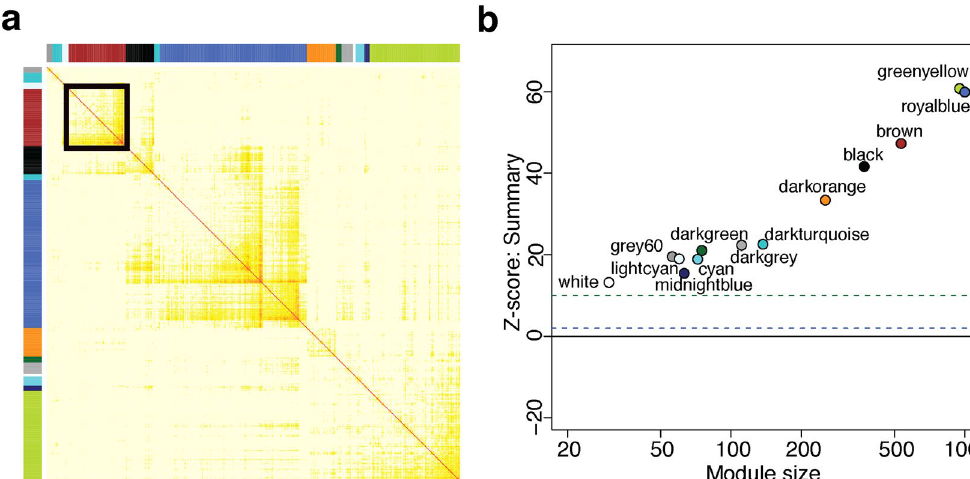
Figure 3. Weighted Gene Co-expression Network Analysis (WGCNA) of total RNA-sequencing data from human dlPFC neurons from cocaine and control cases reveals 13 distinct co-expression modules. ( a ) Each module is labeled by an arbitrary color represented at top and at left, and darker yellow and red represent greater topological overlap. ( b ) Z < 2 (blue line) suggest there is weak evidence for module robustness, while Z > 10 (green line) denotes strong evidence for their reproducibility. Evidence is considered moderate when 10 > Z > 2. All modules identified in dlPFC have Z quality scores > 10 (green line), suggesting there is strong evidence for their robustness and